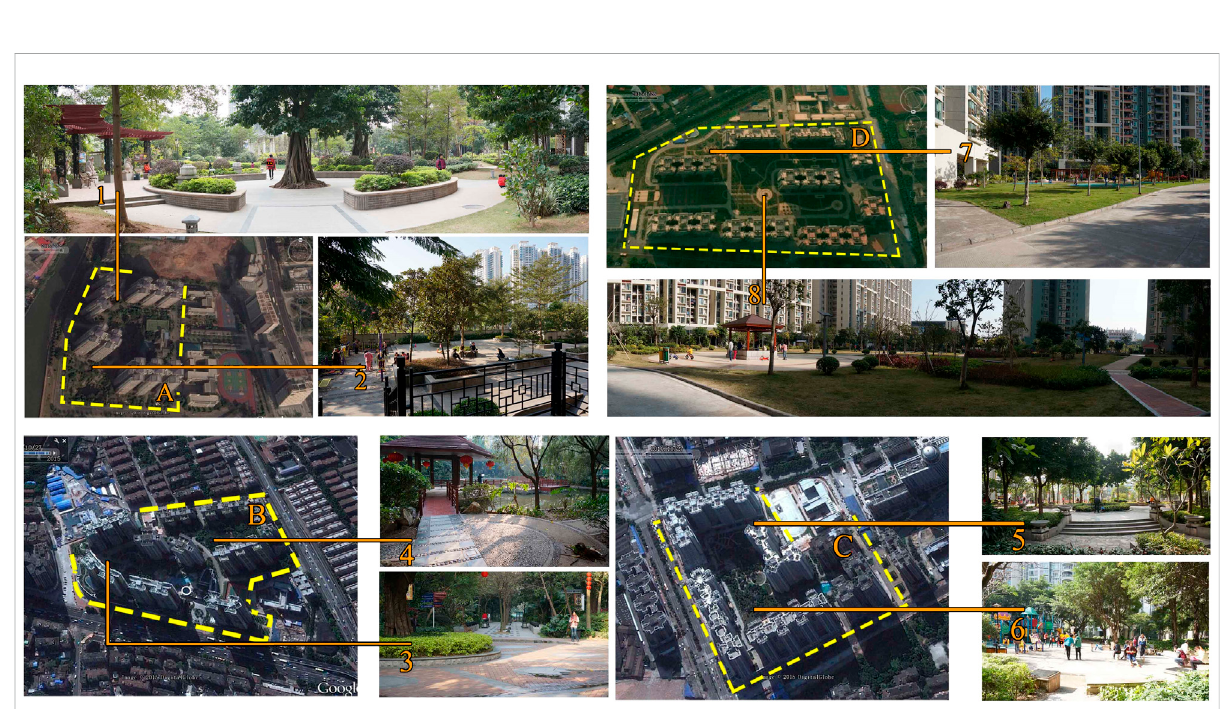
FIGURE 2 Sitescon fi gurations.SitesA1,B3,andB4areshadedandwindless;SiteC5isshadedandwindy;SitesA2andD7aresunlitandwindy;SitesC6and D8 are sunlit and